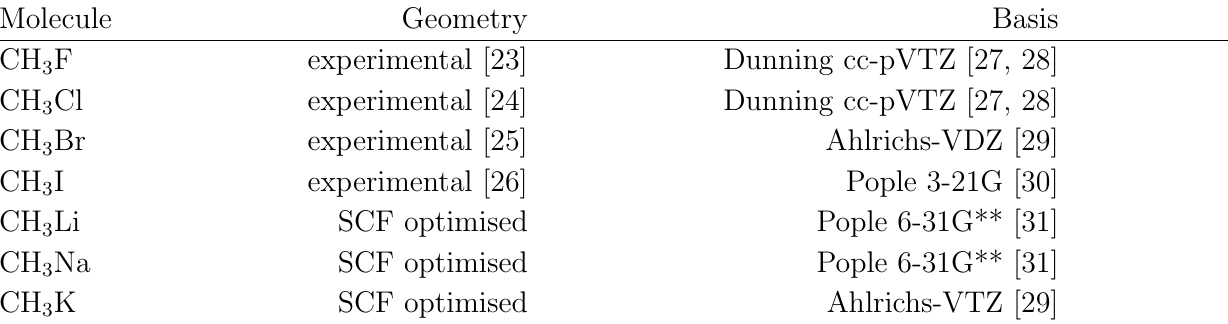
Table 1. Table of Geometries and Basis Sets Used